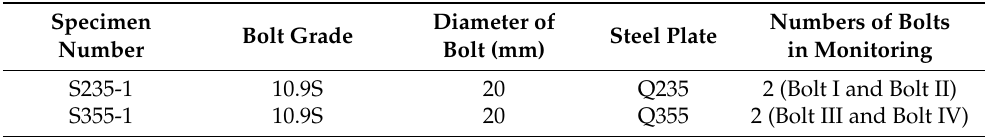
Figure 8. Monitoring scheme for the PF-HSB. Table 2. Monitoring scheme of the